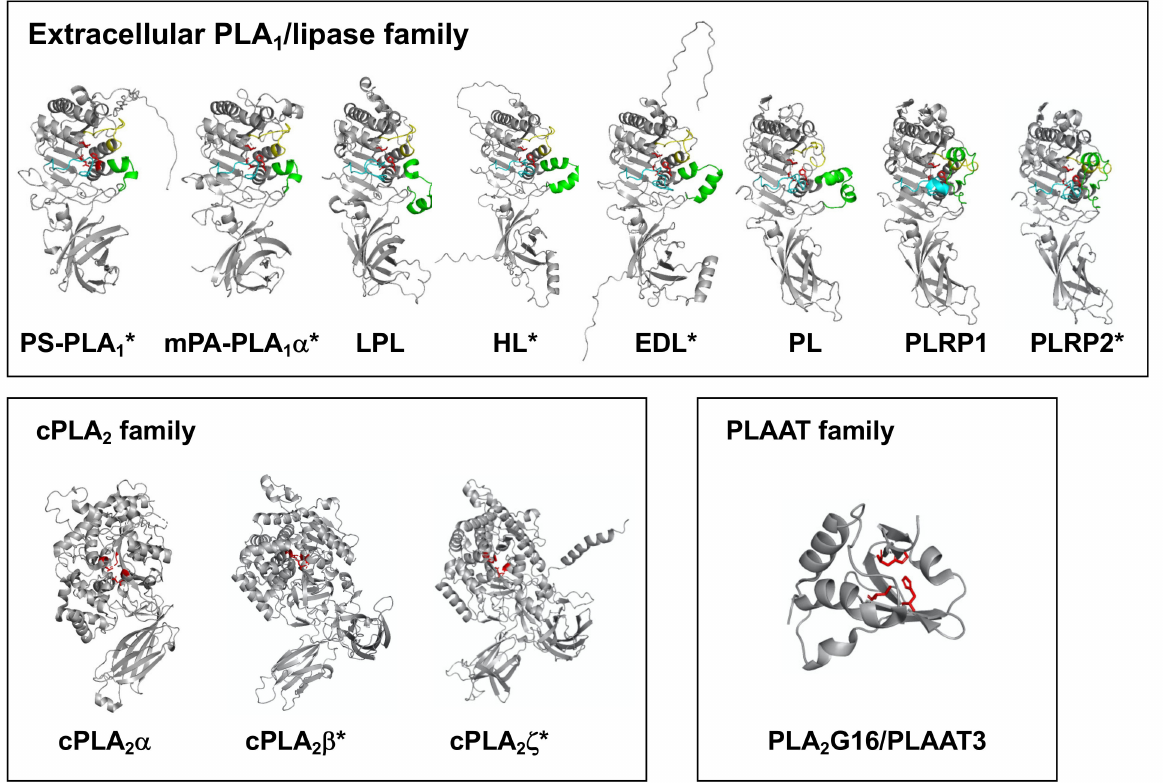
Figure 4. Structures of PLA 1 molecules. 3D structures of three PLA1 family members (extracellular PLA1/lipase, cPLA2 and PLAAT family members) were shown. For extracellular PLA1/lipase family members, β 5 and the β 9 loops and the lid domain are shown in yellow, cyan and green, respectively. The three residues forming a catalytic triad (Ser, Asp and His) are described as sticks (red). For cPLA2 family members (cPLA2 α , cPLA2 β and cPLA2 ζ ), the conserved lipase motifs (GXSGX and DXG) are shown in red, and the two residues forming a catalytic dyad (Ser and Asp) are shown as sticks. For PLAAT3/PLA2G16, the three residues forming a catalytic triad (two histidines and cysteine) are shown as sticks (red). The structures without asterisk were acquired from RCSB Protein Data